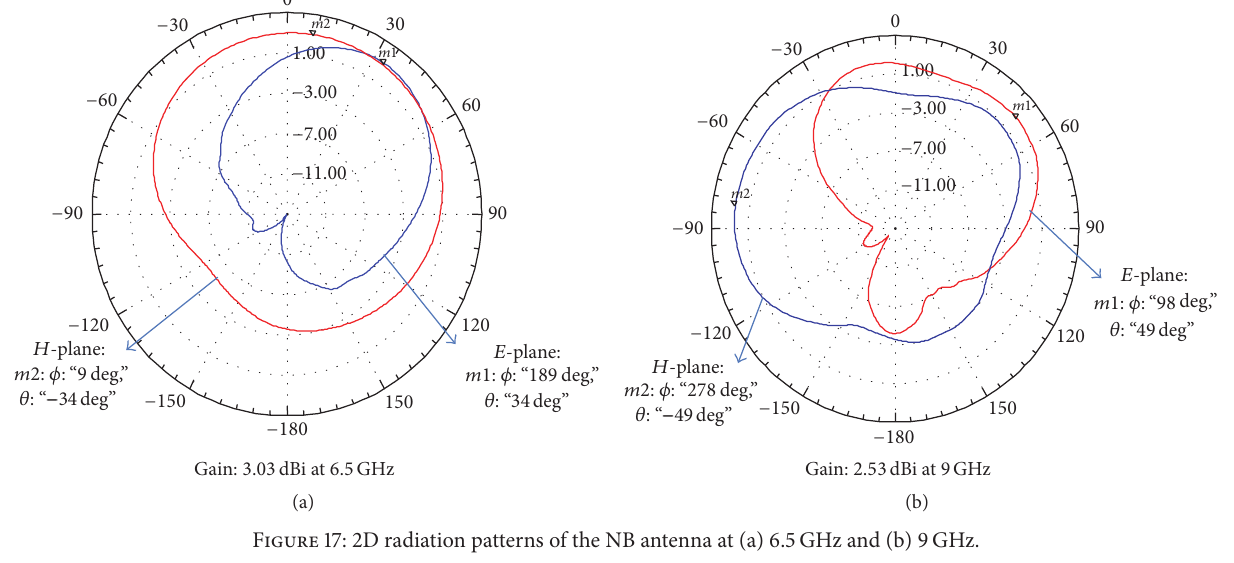
Figure 17: 2D radiation patterns of the NB antenna at (a) 6.5 GHz and (b) 9 GHz.